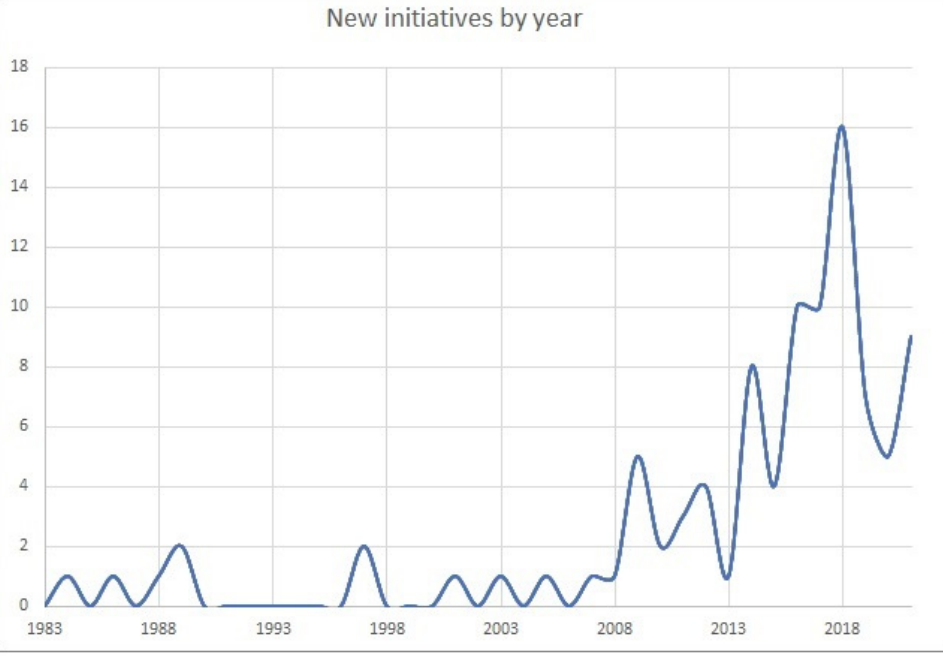
Figure 3. New initiatives by year, since 1983. The number of initiatives started during each year, excluding one initiative founded in 1965 to improve viewability.